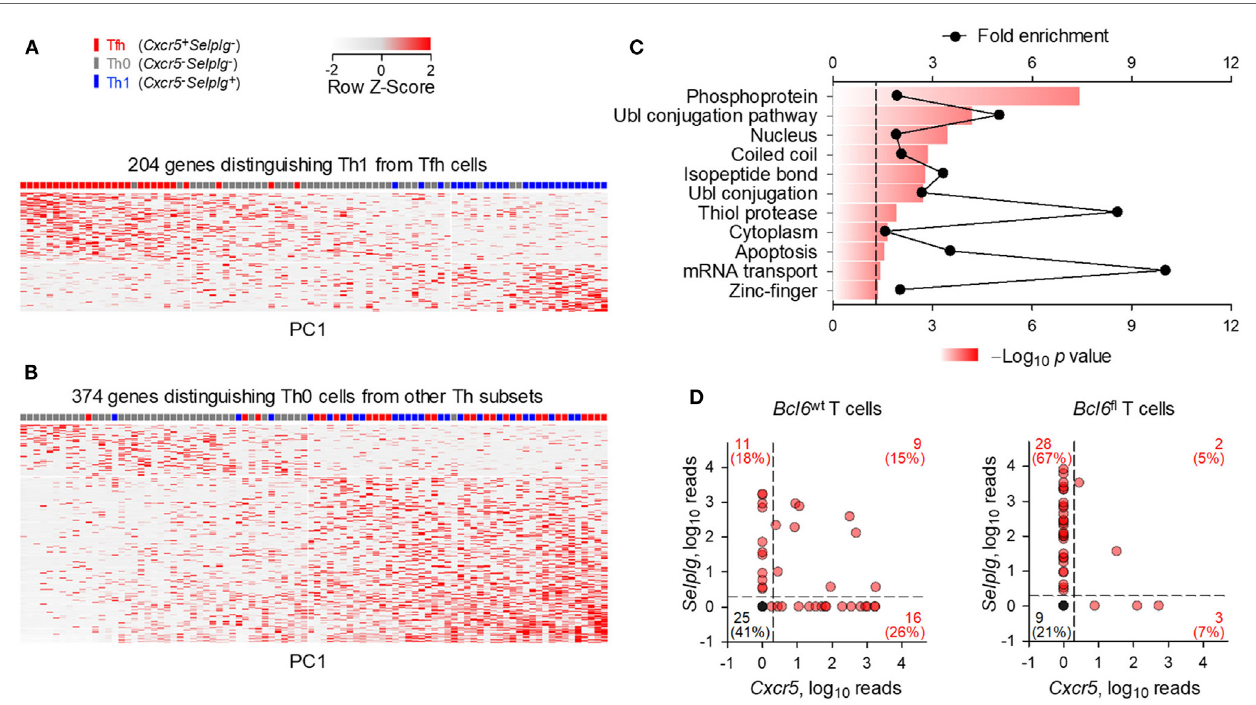
FigUre 2 | Distinct transcriptional profile of uncommitted Th0 cells. Gene expression previously assessed by single-cell RNA-sequencing of env-reactive donor CD4 + T cells isolated from the spleens of WT recipients infected with Friend virus (FV) or immunized with Ad5.pIX-gp70. (a) Heatmap of expression values of the 204 most differentially expressed genes ( ≥ 2-fold change, p ≤ 0.05) between Th1 and follicular helper (Tfh) cells. (B) Heatmap of expression values of the 374 most differentially expressed genes ( ≥ 2-fold change, p ≤ 0.05) between Th0 cells and the other two subsets. Each row and column is an individual gene and cell, respectively, plotted according to their order in principal component analysis. (c) Functional pathways revealed by enrichment analysis on genes differentially upregulated ( ≥ 2-fold, p ≤ 0.05, q = 0.05) between Th0 cells and the other two subsets. (D) Cxcr5 and Selplg expression in Bcl6 wt and Bcl6 fl env-reactive donor EF4.1 CD4 + T cells purified from the spleens of recipient mice, 7 days after FV infection. Each red symbol represents an individual cell, whereas single black symbols are plotted for all the cells where Cxcr5 and Selplg expression was